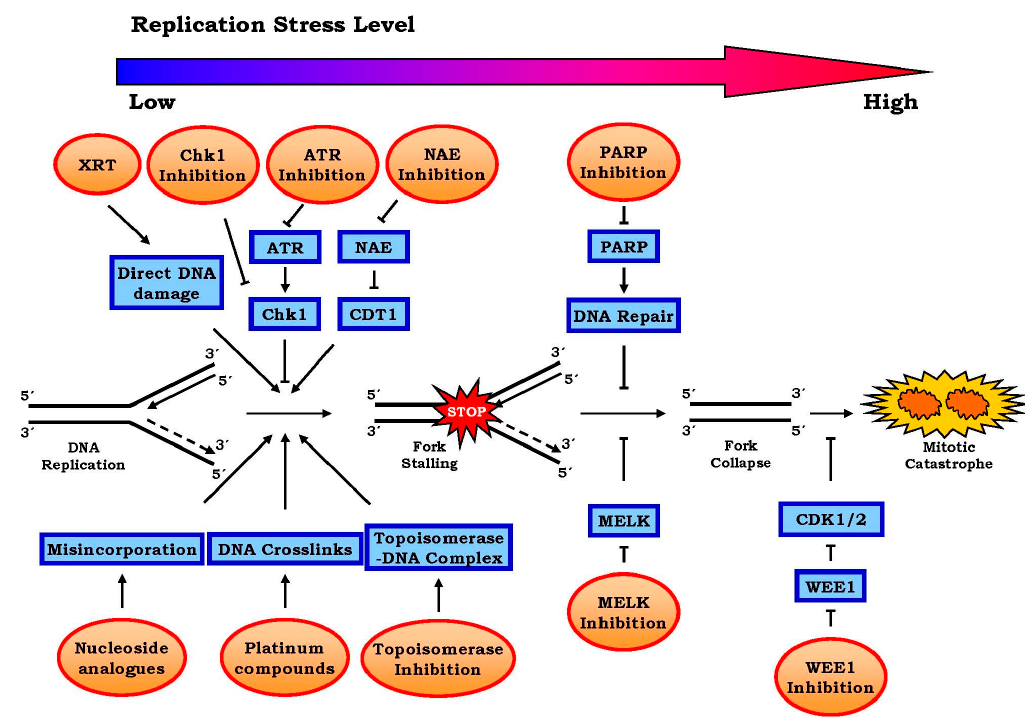
Figure 2. Illustration of various approaches to target replication stress for cancer treatment. For simplicity, only the approaches that have been discussed in the text are illustrated here. As indicated, with the progression from DNA replication fork stalling to folk collapse and eventually premature entry of mitotic phase, there is accompanying enhancement of DNA replication stress. Shown here are different approaches exploited to enhance this stress level. While chemotherapeutic agents use different approaches to induce fork stalling (e.g., nucleotide disincorporation, DNA crosslinks and topoisomerase—DNA complex), radiation (XRT) induces direct DNA damage. These genetic errors activate ATR-Chk1 signaling which prevents further fork stalling. Therefore, inhibitors of either ATR or Chk1 may enhance replicative stress. Since both PARP and MELK prevent the progression to fork collapse, their corresponding inhibitors may also augment the level of replicative stress. Because the ubiquitin ligase substrate CDT1 causes DNA to replicate more than once and its activity is inhibited by neddylation, the NAE inhibitor can also be used to achieve this purpose. Finally, WEE1 inhibitor activates CDK1/2, therefore facilitating premature entry to S phase. The final consequence of all these approaches is cell death through mitotic catastrophe that is induced by the enhancement of replicative stress.